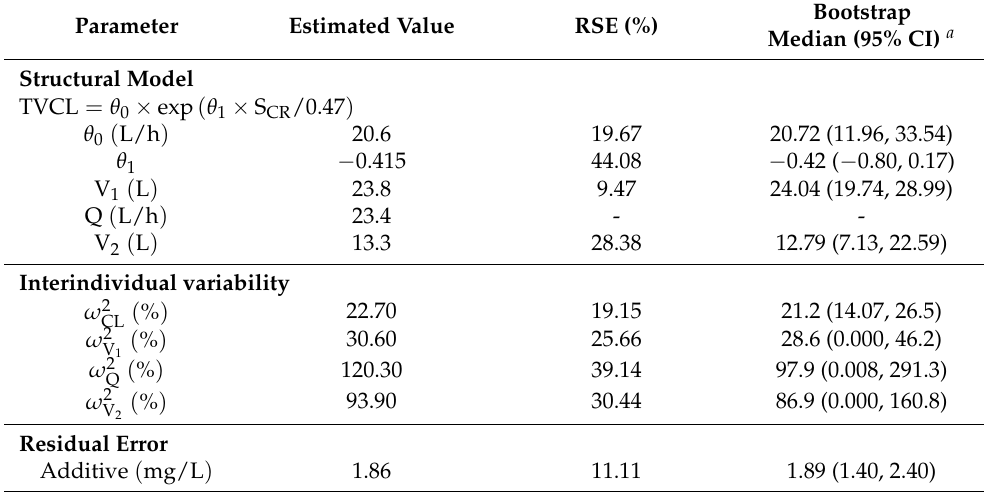
Table 2. Population pharmacokinetic parameters of cefepime in patients with CIFN.